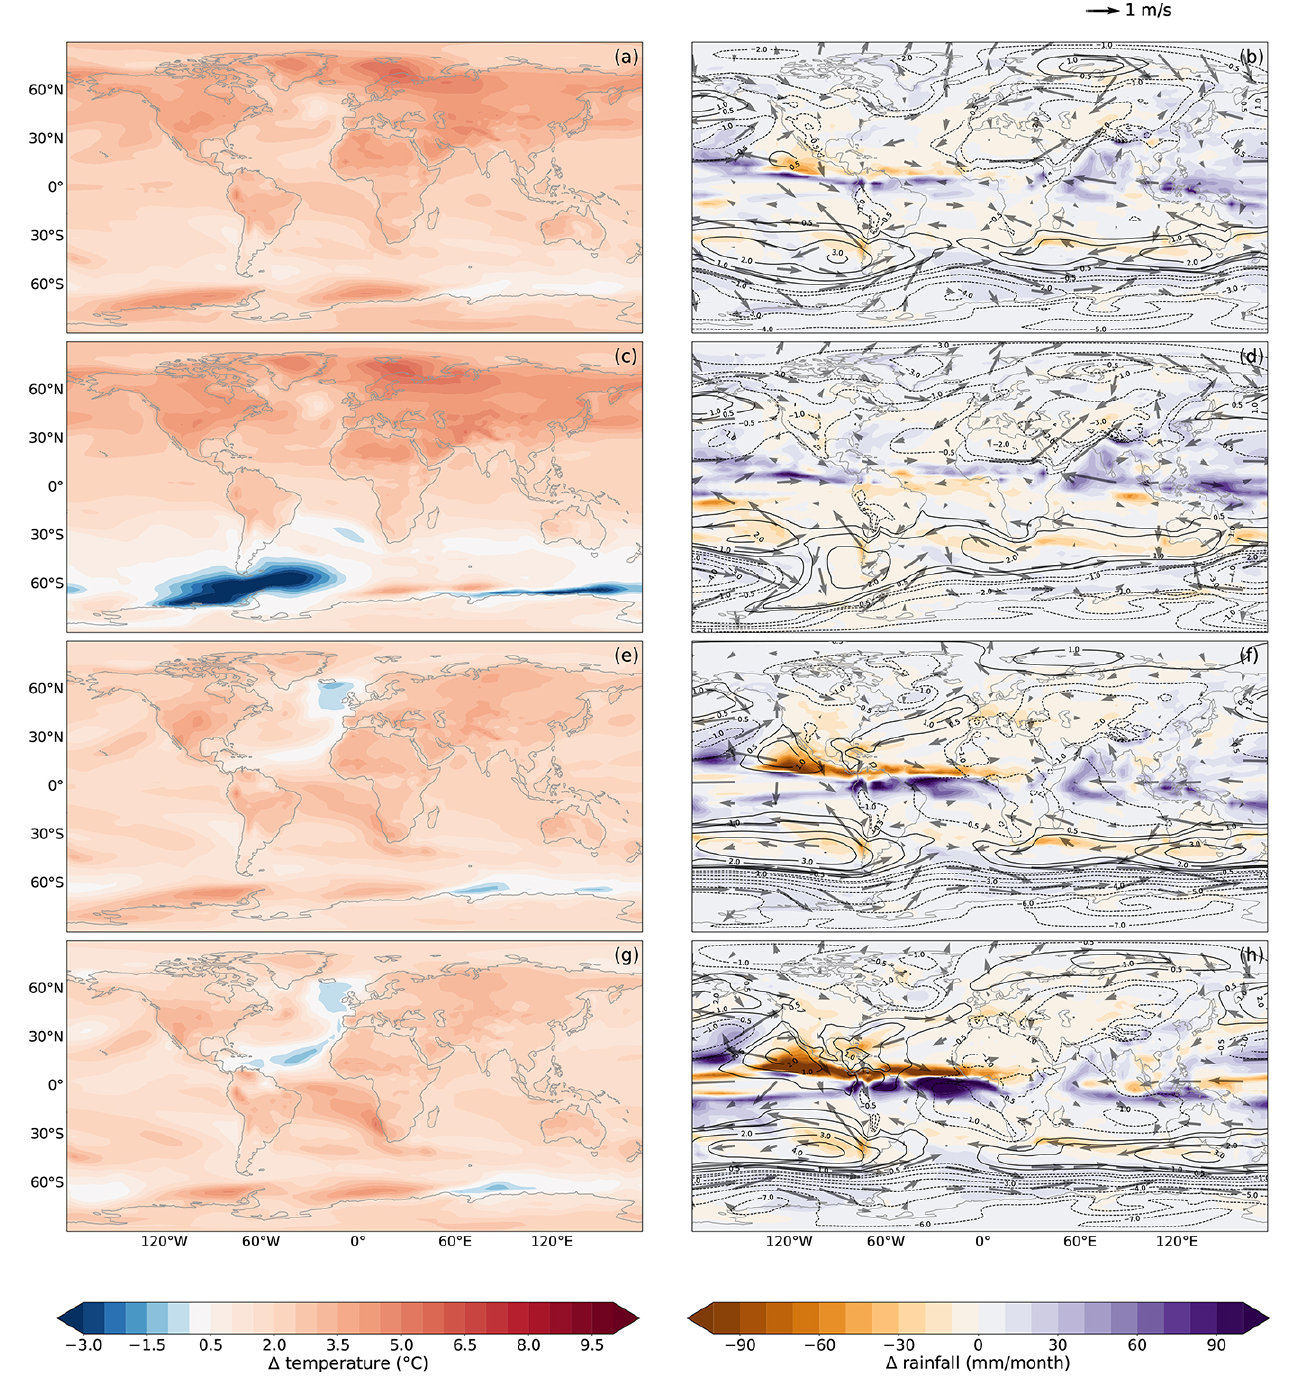
Figure 4. Difference between future scenarios (2041–2070) and historical simulation (1976–2005) for the boreal summer season (MJJAS). The left column depicts the surface temperature difference (a, c, e, g) , and the right column shows the difference in rainfall (shading), SLP (black contours, dashed lines for negative values) and wind at 850hPa (vectors) (b, d, f, h) . The future scenarios are (a, b) RCP85, (c, d) WAIS3m, (e, f) GrIS1m and (g, h) GrIS3m.